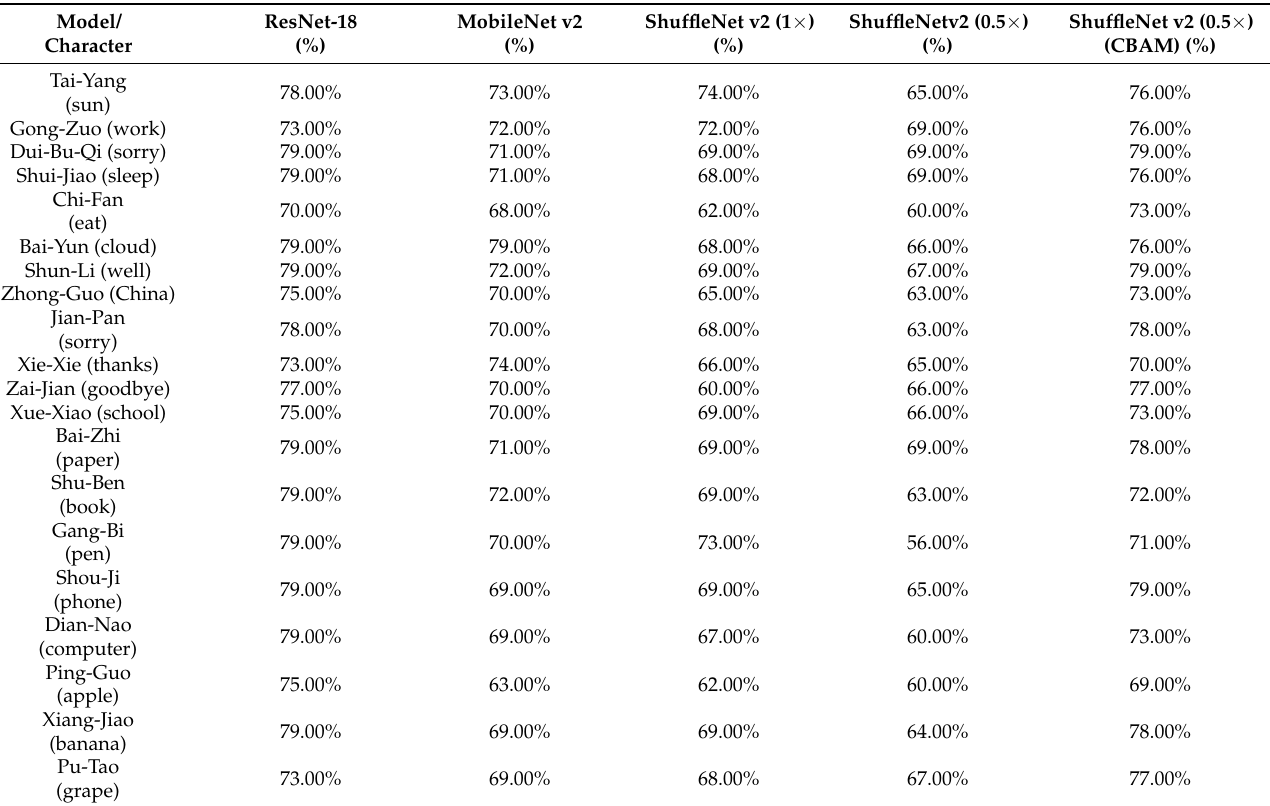
Table 4. Partition of the results of different models on some words.